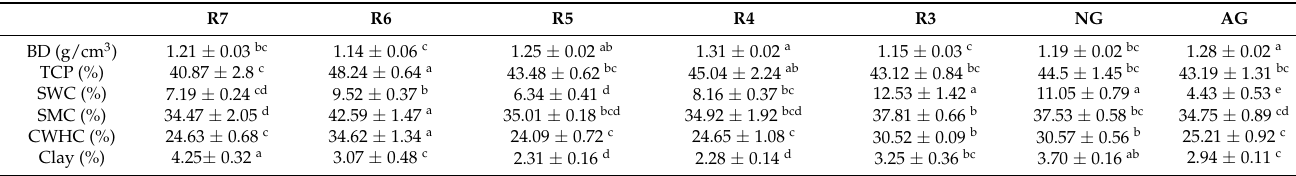
Table 3. Soil physical and chemical